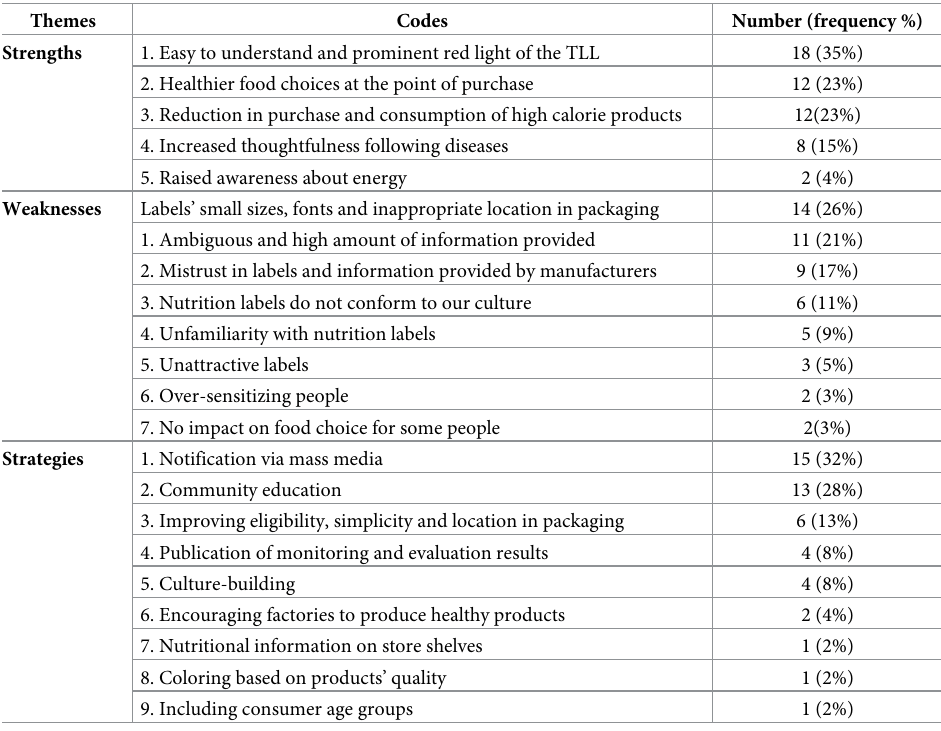
Table 3. Strengths, weaknesses and strategies for improving the use of nutrition labels, based on mothers’ viewpoints.